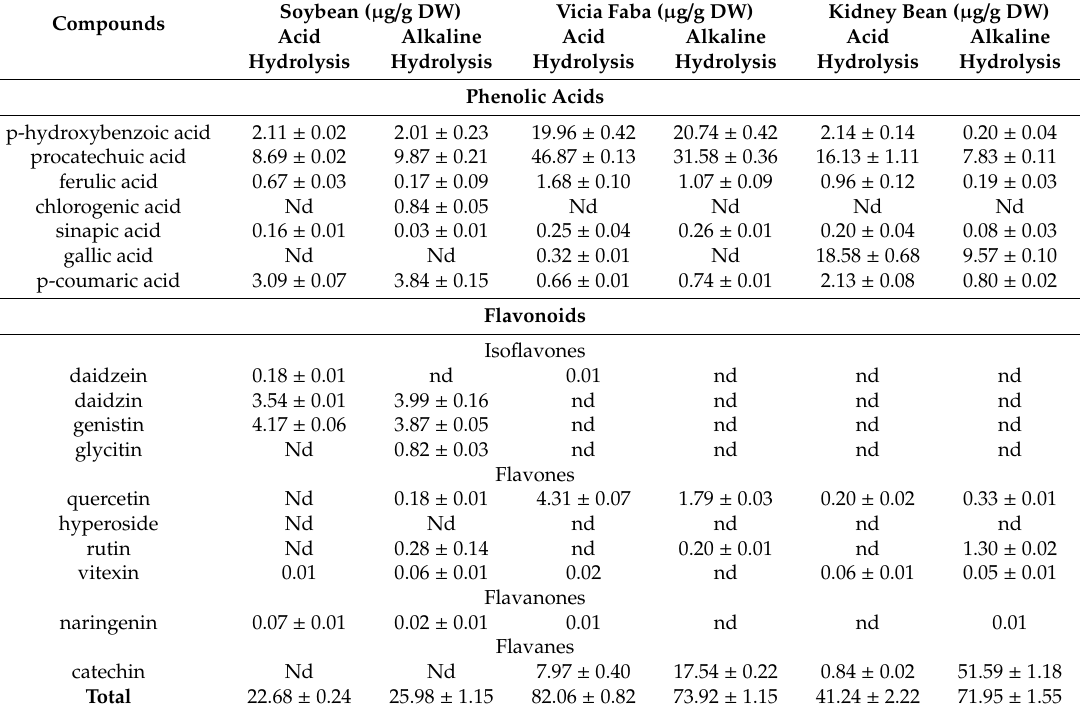
a Results are expressed as mean ± standard deviation of three